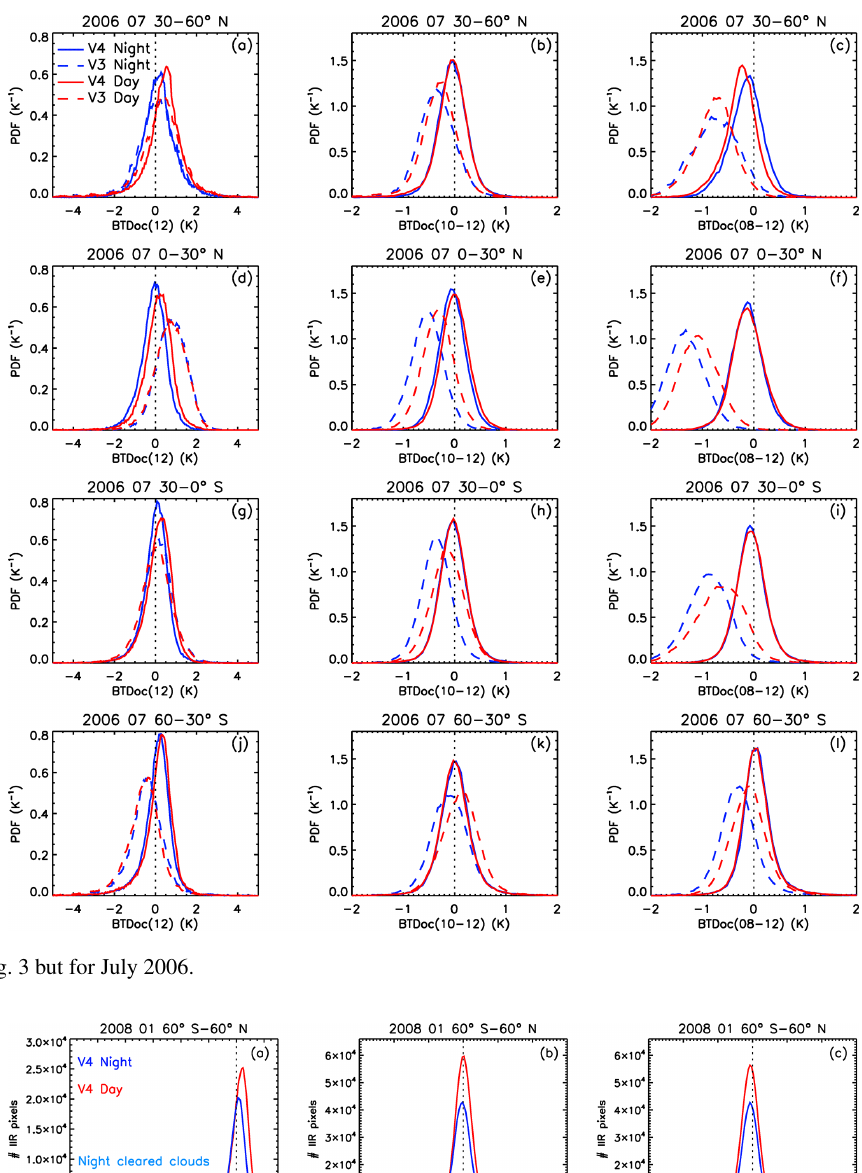
Figure 5. Histograms of the differences between observed and computed brightness temperatures over oceans between 60 ◦ S and 60 ◦ N in January 2008 in V4 clear-sky conditions (no cleared clouds) (navy blue: night; red: day) and in pseudo-clear-sky conditions (cleared clouds in the column) (light blue: night; orange: day). (a) BTDoc at 12.05µm; (b) 10–12 and (c) 08–12 inter-channel BTDoc